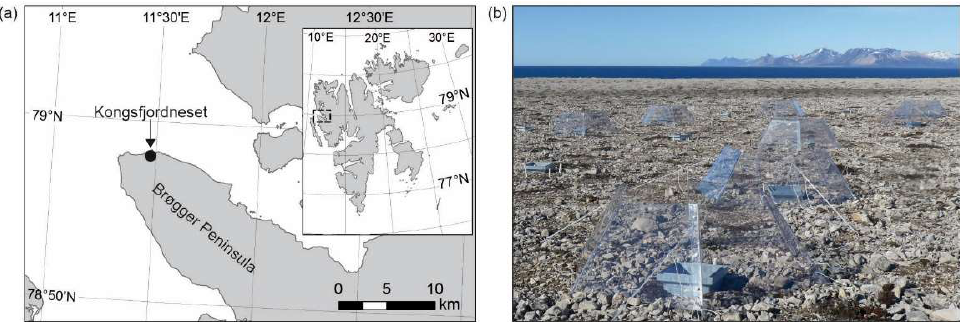
Figure 1. ( a ) Map showing the location of Kongsfjordneset. Inset shows the location of Svalbard, with the dashed box denoting the area shown in the main Figure. ( b ) Image of the field experiment at Kongsfjordneset, showing eight of the 24 open top chambers (OTCs) used to warm soil. The OTCs have a basal diameter of 1.04 m. Note the stainless steel frames used to trap gases during flux meas- urements.